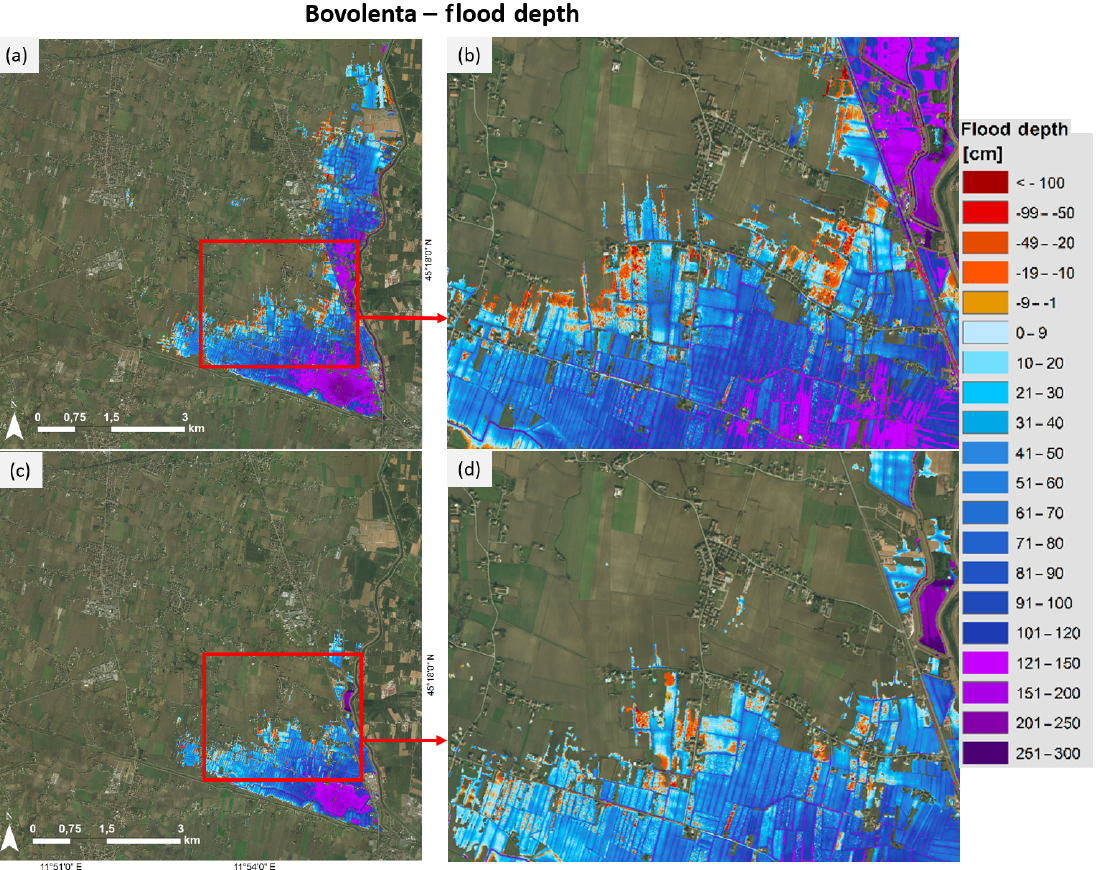
Figure 7. Flood depth for the Bovolenta area of study on (a) 4 November and (c) 6 November. Panels (b) and (d) show a zoom of the results, highlighting the high level of detail achievable. Reddish pixels represent the error in the water level